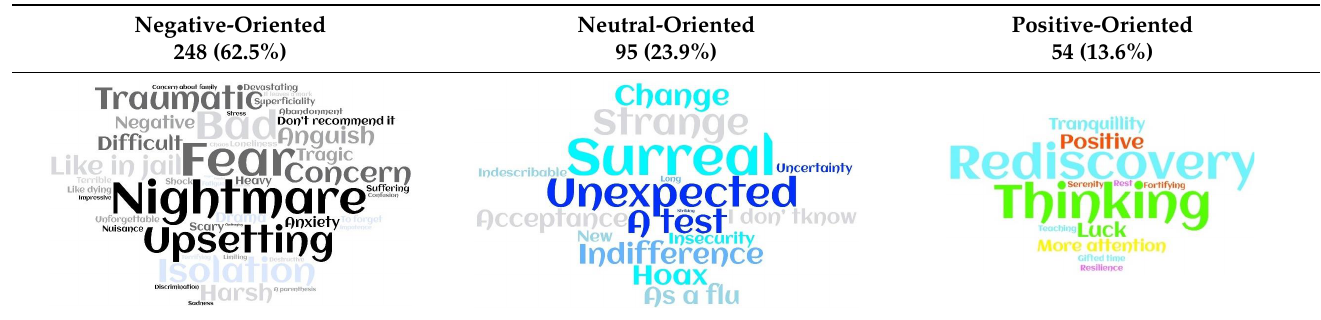
Supplementary Table 3. ‘ My lived experience as a COVID-19 survived patient ’ : metaphors according and their orientation (=397). Negative-oriented 248 (62.5%)